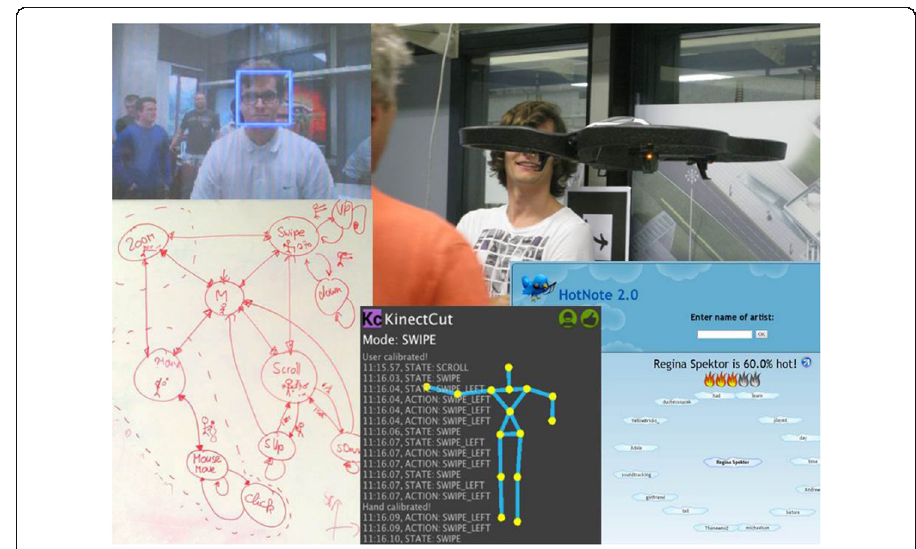
Fig. 1 Project examples from the Océ Dev